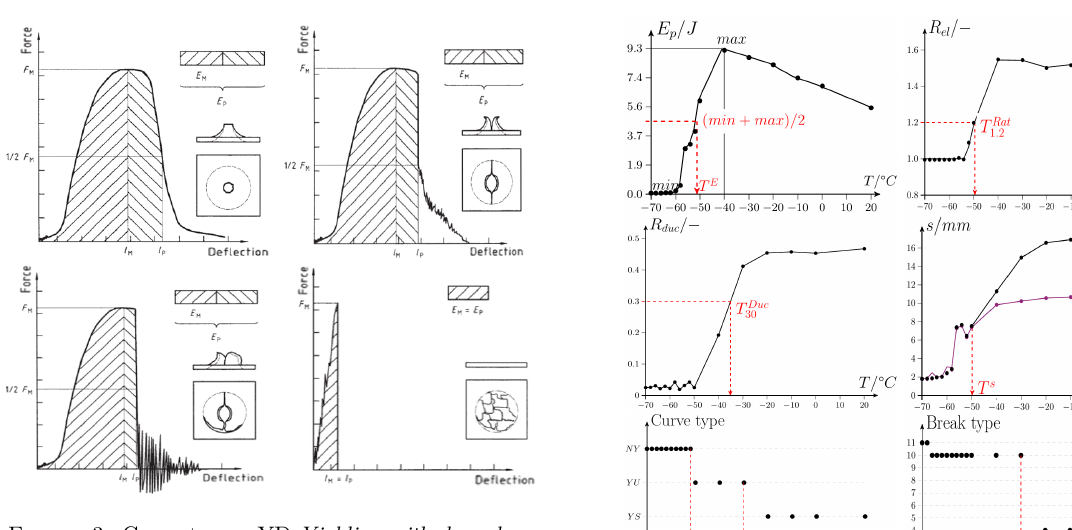
Figure 3. Curve types: YD Yielding with deep draw- ing (top left), YS Yielding with stable crack (top right), YU Yielding with unstable crack (bottom left), NY No yielding (bottom right) [2].